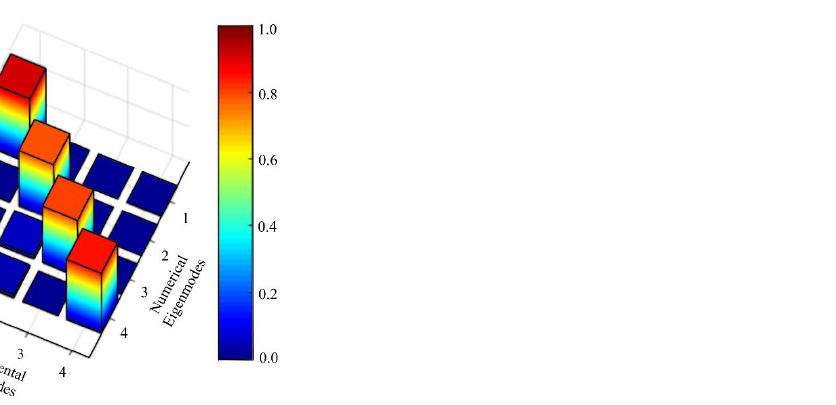
and numerical approaches.